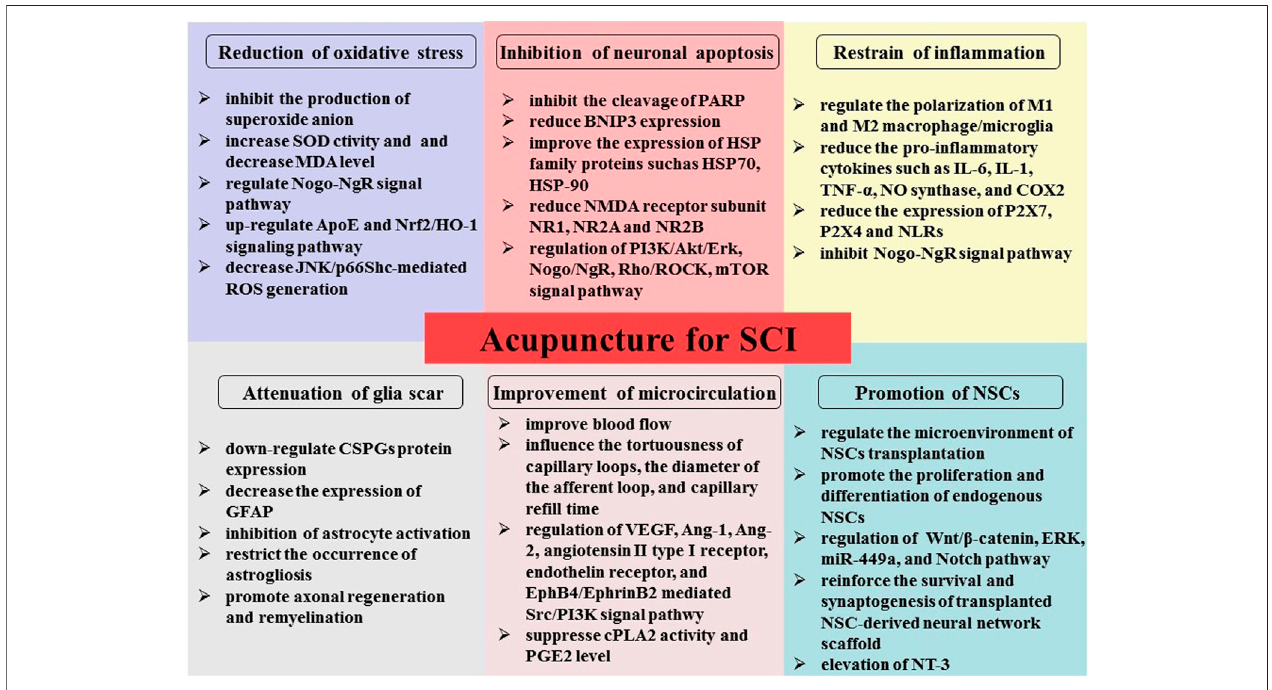
FIGURE 1 | Illustration of the possible mechanism underlying acupuncture therapy in SCI, including oxidative stress reduction, in fl ammation and apoptosis inhibition, microcirculation improvement, reduction of glial scar formation, and stimulation of NSC differentiation and proliferation.